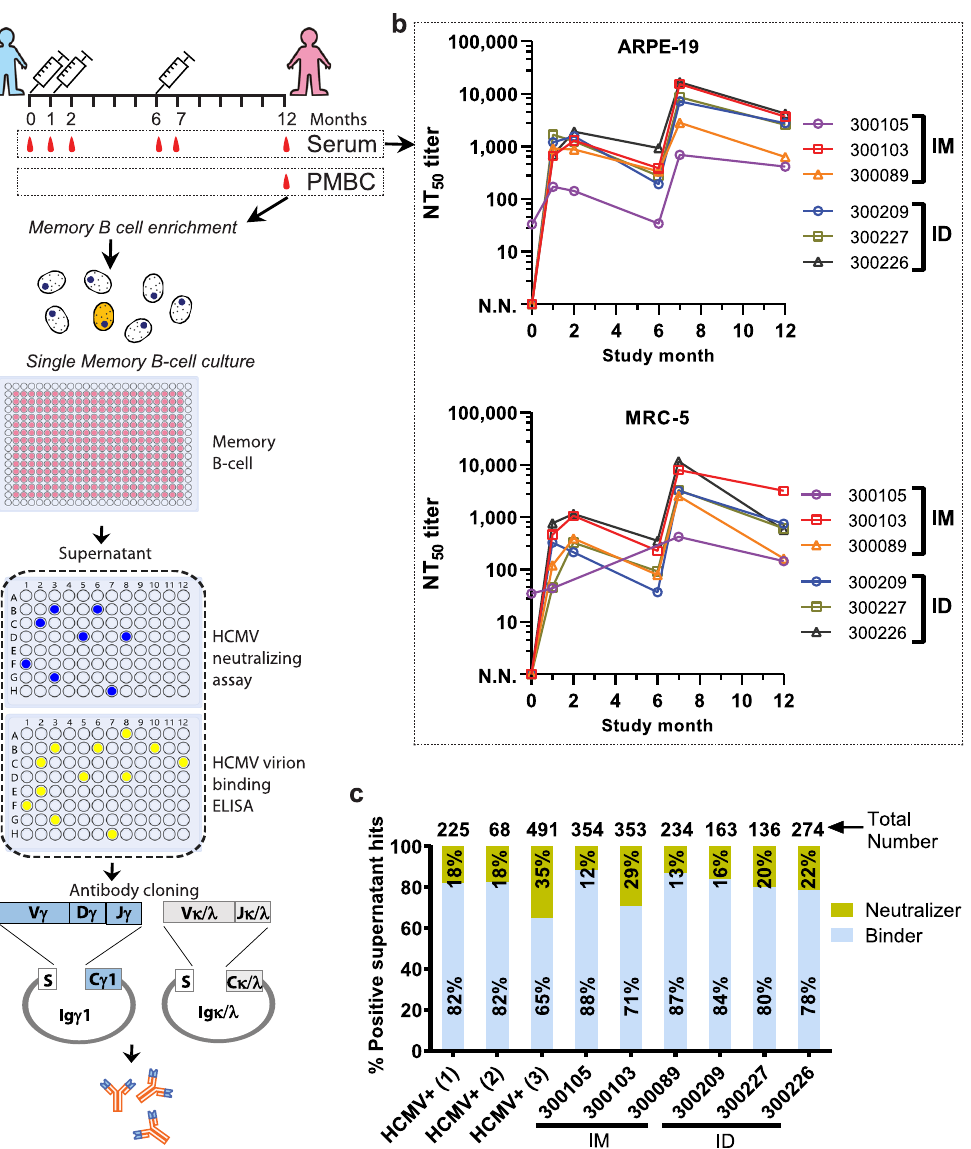
Fig. 1 The isolation of V160-elicited monoclonal antibodies from human subjects. a Flowchart of monoclonal antibody isolation by single B-cell culturing and antibody cloning. After three-dose vaccination, the memory B cells were isolated from six subjects and cultured in 384- well plates. After 14 days, the single-cell culture supernatants were tested for HCMV neutralization in ARPE-19 cells and HCMV virion binding. Positive supernatants were selected based on the neutralizing and binding activity, and antibody genes were cloned from the positive wells. The antibodies were expressed and puri fi ed for binding and neutralization assays, and epitope mapping. b Longitudinal neutralizing titers of V160-vaccinated subjects in ARPE-19 and MRC-5 cells. Three subjects (300105, 300103, 300089) were injected intramuscularly (IM), another three subjects (300209, 300227, 300226) were injected intradermally (ID). The serum of the subjects was taken at six time points: month 0, 1, 2, 6, 7, and 12. The reciprocal serum dilution that achieves 50% viral neutralization (NT 50 ) was calculated using a four-parameter curve fi tting. c Functional distribution of neutralizing and binding antibodies in the screening with supernatants of single memory B-cell cultures. The numbers of positive hits for each subject are placed above the columns. The percentages of neutralizers and binders in each subject are labeled in the columns. Three HCMV-seropositive subjects (HCMV + ) are positive controls. N.N. indicates no neutralizing